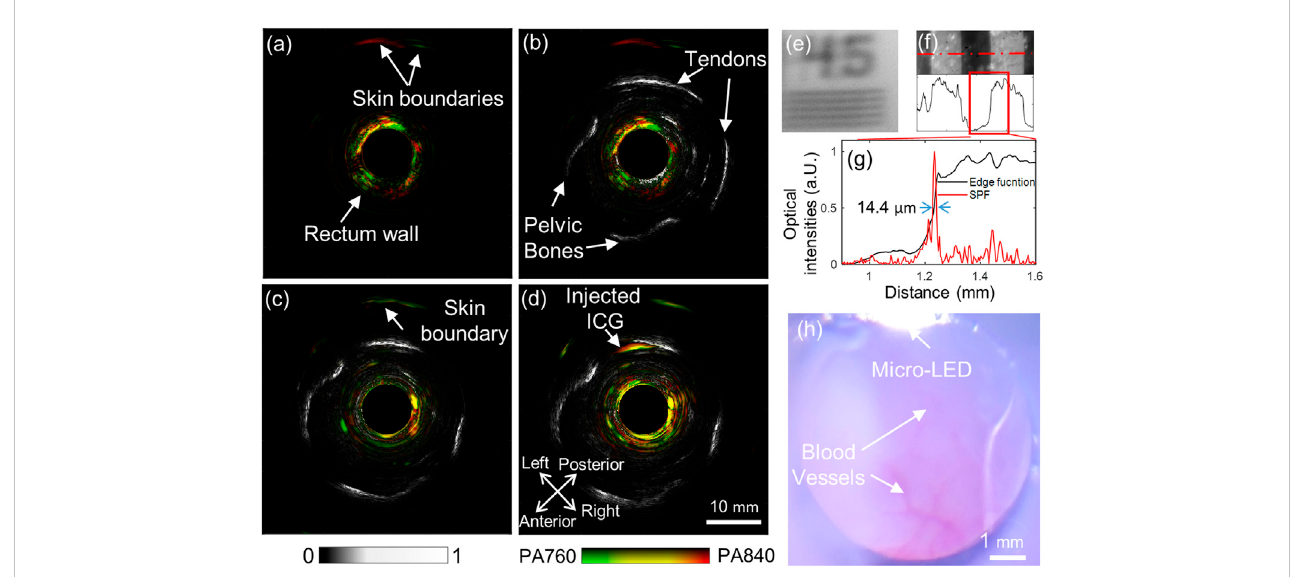
FIGURE 5 Multi-functional endoscopic imaging results of the rabbit rectum. (A) Fused photoacoustic image of 760 and 840 nm; (B) Fused dual-wavelength photoacoustic and ultrasound image; (C) and (D) , fused dual-wavelength photoacoustic and ultrasound images before and after a dose injection of ICG, respectively; (E) and (F) are the acquired wide- fi eld optical endoscopic image of a positive resolution test target plate, with patterns of 45 circle/mm and 1.0circle/mm, respectively; (G) Edge function(black)and derivedPSF (red)ofthewide- fi eldopticalendoscopy, obtained from thedata along thedotted red line in (F) ; (H) The wide- fi eld optical image of the rectum inner surface.